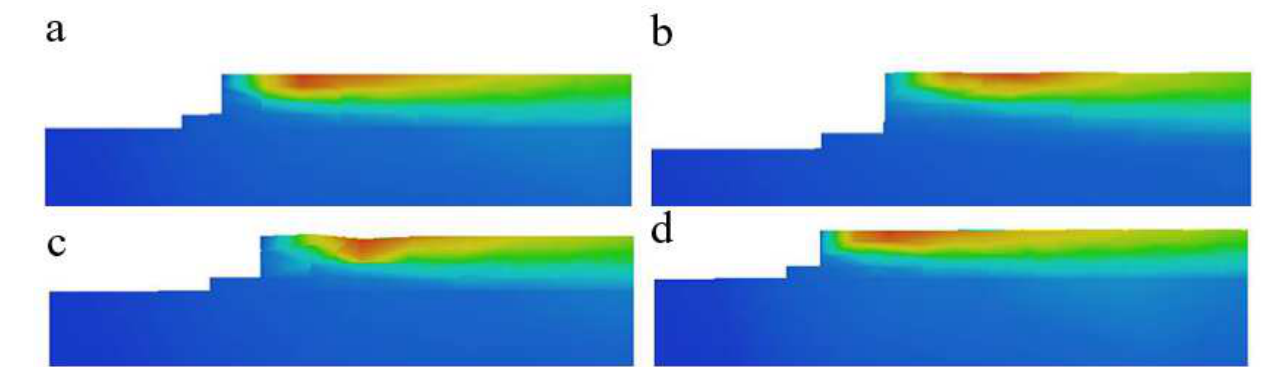
Figure 13. Cross-sectional view of SLM melt pool: ( a ) E = 83.3 J/mm 3 , ( b ) E = 41.7 J/mm 3 , ( c ) E = 111.1 J/mm 3 , and ( d ) E = 57.1 J/mm 3.